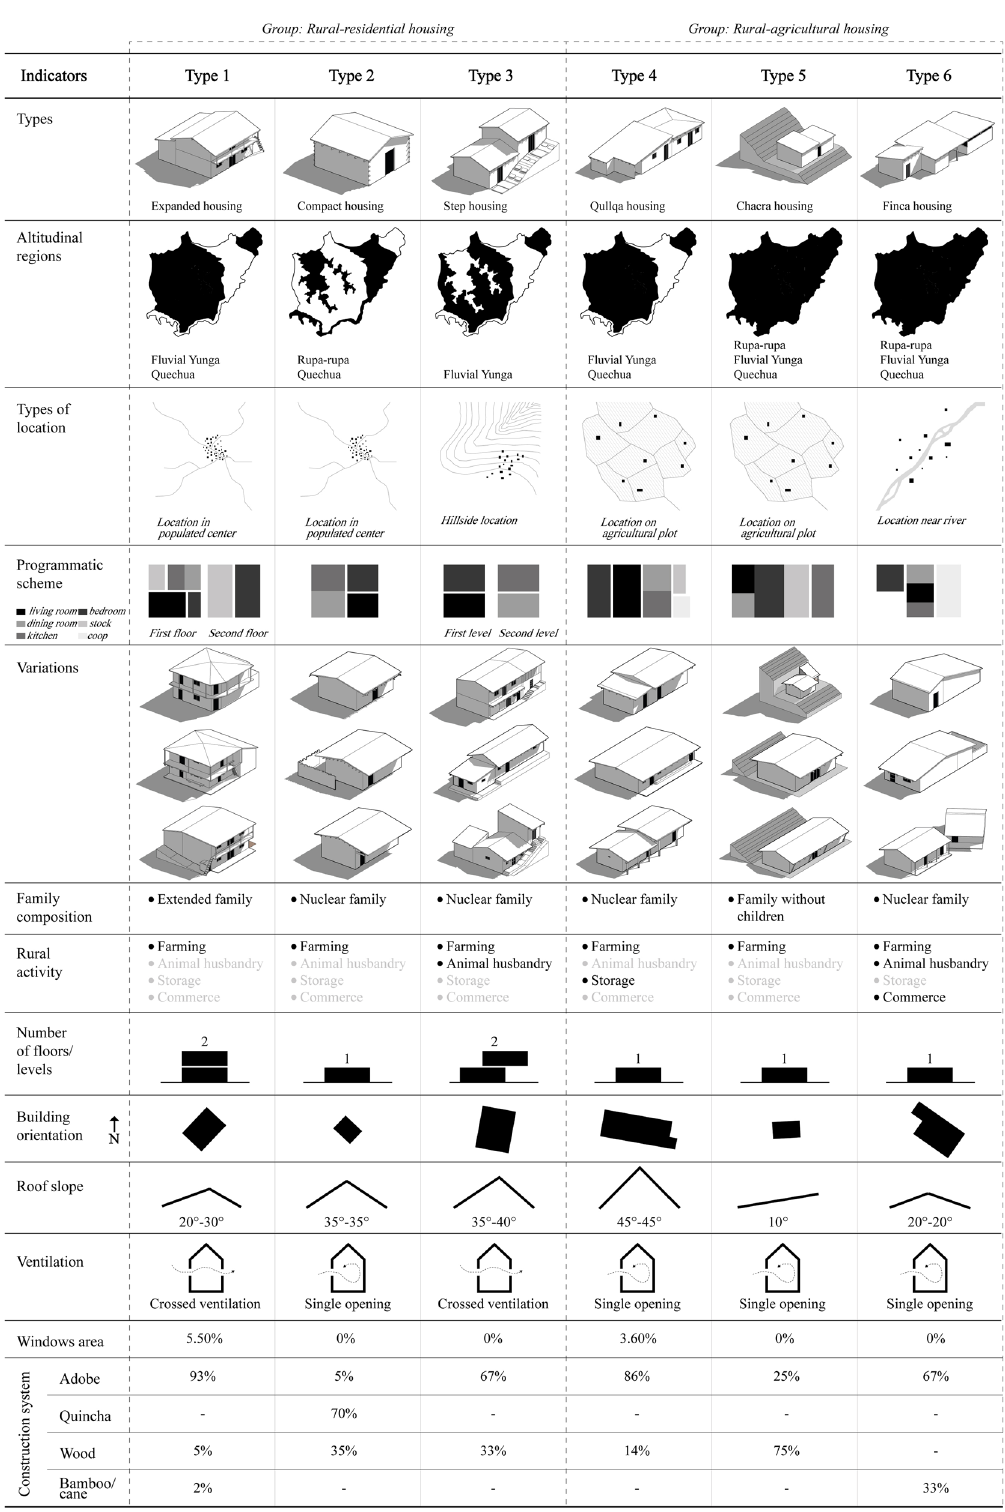
Fig. 9 Architectural types of rural housing in Jaén (Source: the